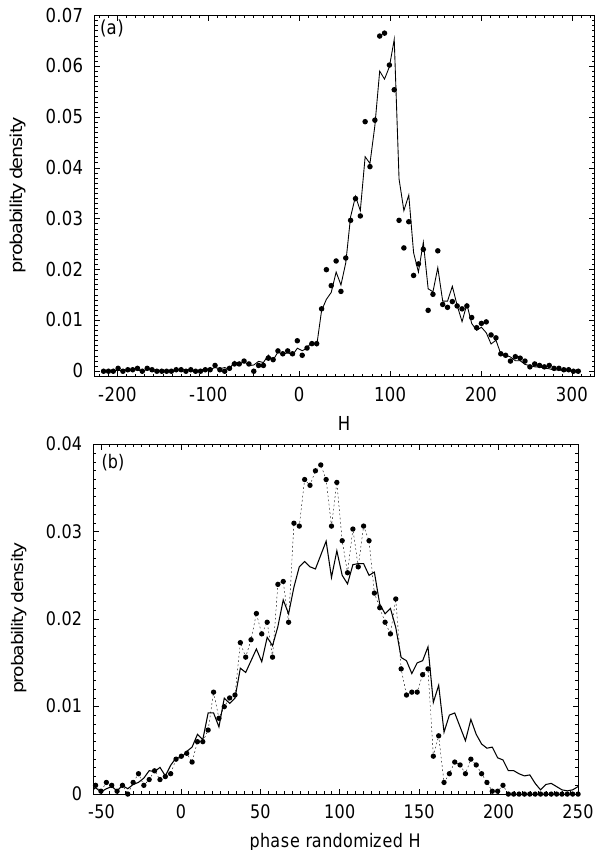
Fig. 9. (a) The probability density function of the original time series of H based on the entire time series (solid line) and on the first half of the series (filled circles). (b) The probability density function of the phase randomized time series of H based on the entire time series (solid line) and on the first half of the series (dashed line with filled circles).